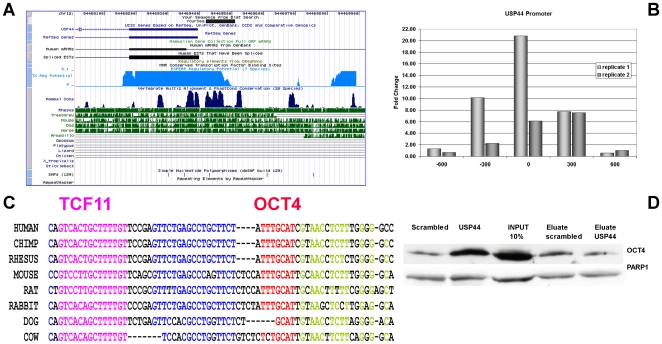
The USP44 promoter harbours the evolutionary conserved OCT4 binding site but lacks the SOX2 motif.A: Sequence containing the conserved POU site as displayed by the UCSC genome browser. B: Real time PCR confirmation of the presence of the OCT4 binding site. Position 0 indicates the conserved region seen in (A). C: Multiple alignments showing evolutionary conservation of the OCT4-bound region. The sequences depicted in blue and green are uncharacterised with respect to transcription factor recognition and binding. D: Western blot analysis of proteins bound to biotinylated oligos representing the promoter fragment shown in (A). The OCT4 antibody shows higher binding intensity to the USP44- specific probe compared to the corresponding scrambled oligo.